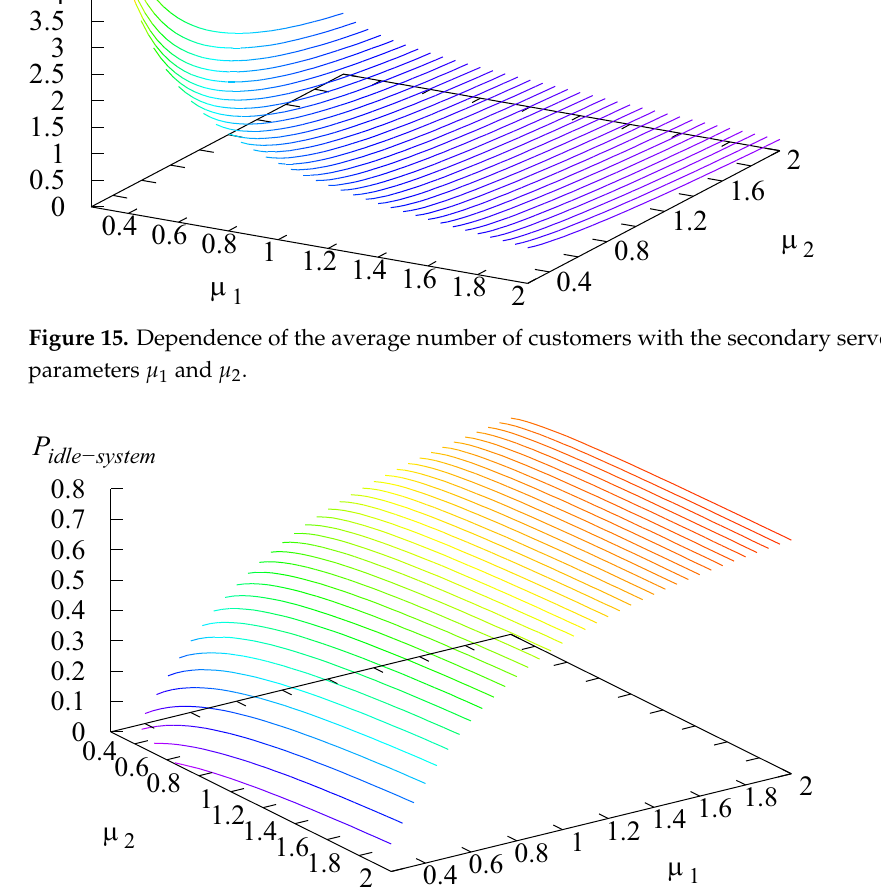
Figure 16. Dependence of the probability P idle − system that the system is idle at an arbitrary moment on the parameters µ 1 and µ 2 .